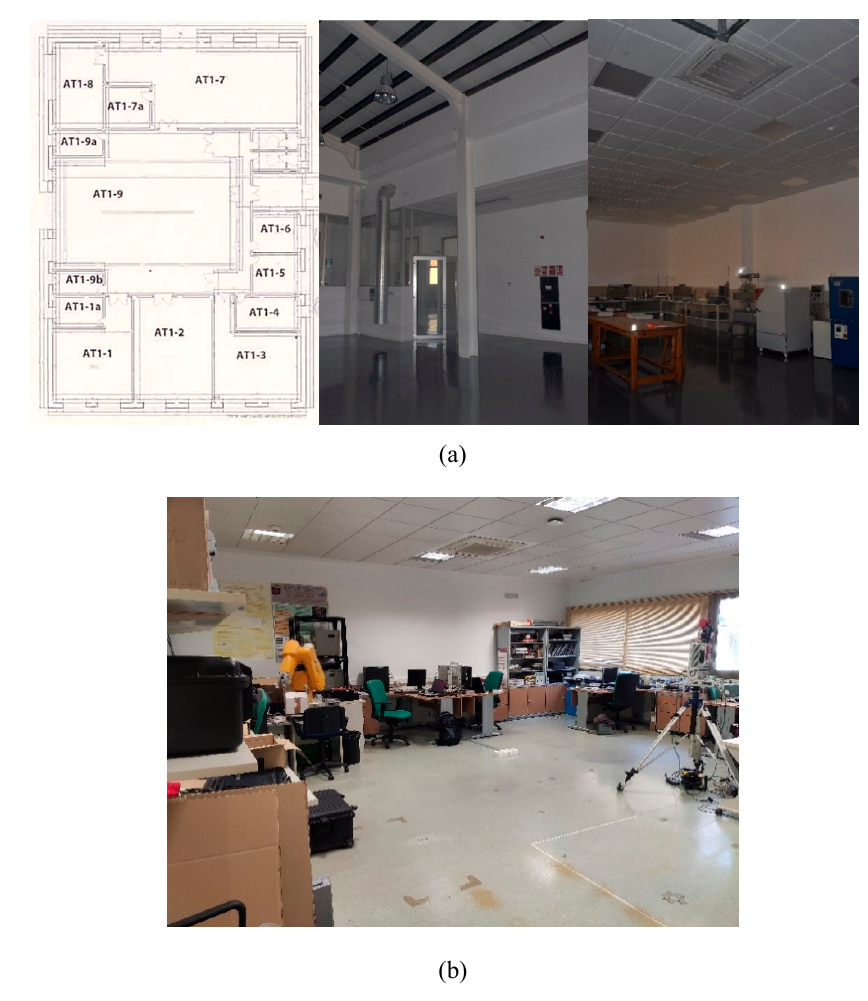
Figure 9. ( a ) First scenario. Blueprint and pictures of some rooms. ( b ) Second scenario.